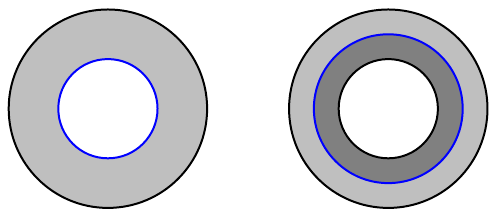
Figure 5 . (Color online) Left: constant time slice of each single-sided BTZ black hole is an annulus. The inner boundary in blue denotes the horizon. Time evolution of this slice corresponds to rotating angle (cid:25) around the inner blue boundary. Right: gluing the constant time slices of single-sided black holes R (light grey) and L (dark grey) along the horizon (blue line) in the middle.